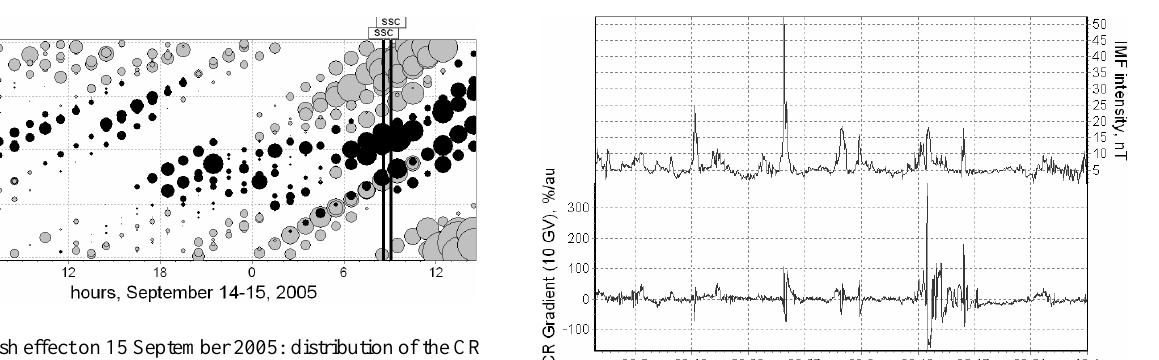
Figure 3: Forbush effect on September 15, 2005: Behavior of the CR density and vector of equatorial component of CR anisotropy in the period from September 15-18, 2005. The dates are presented in the format dd.hh (days.hours). Designations are the same as in Fig.2.